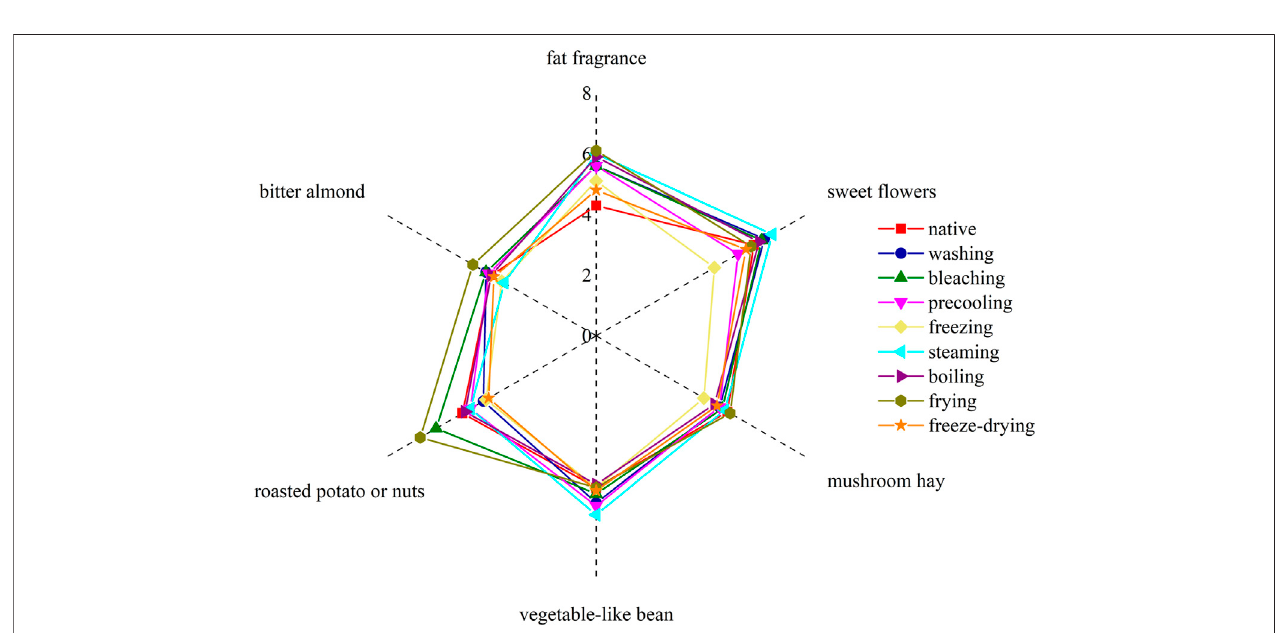
FIGURE 5 | Sensory score of each note in corn under nine kinds of different treatments.